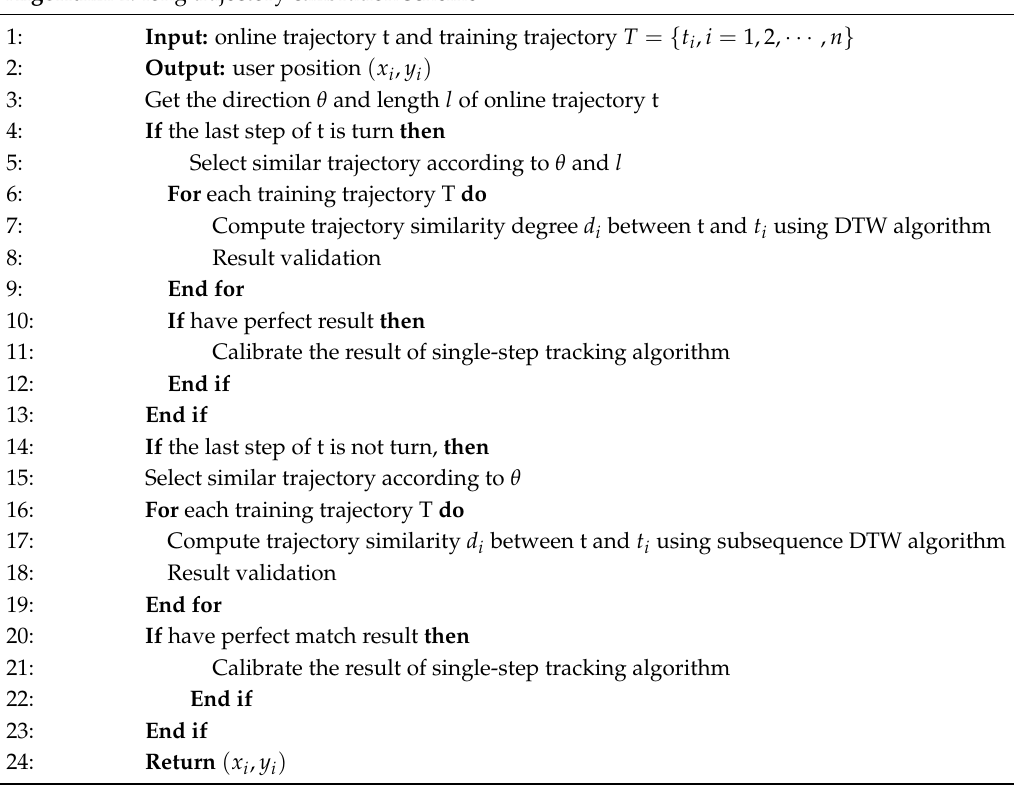
Algorithm 1. long trajectory calibration